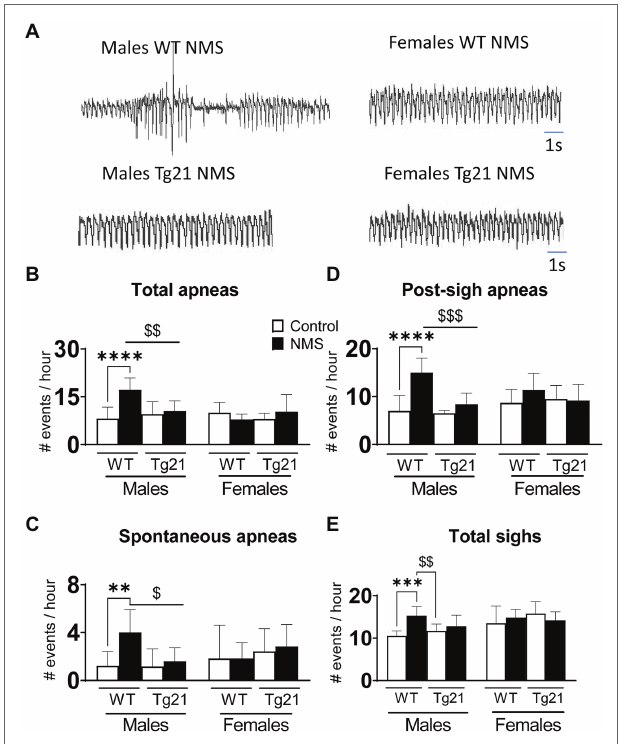
FIGURE 3 | Number of apneic (total, spontaneous, and post-sigh) and sighs events in male (WT: control n = 9; NMS n = 9; Tg21: control n = 7; NMS n = 7) and female (WT: control n = 6; NMS n = 6; Tg21: control n = 8; NMS n = 6) mice previously exposed (or not – control) to NMS. (A) Original recordings comparing resting respiration records between WT and Tg21 male and female animals exposed to NMS. The number of total (B) , spontaneous (C) , and post-sight apneas (D) and total sight (E) were significantly increased in NMS-exposed male WT mice. No effect of NMS was observed in male Tg21 mice, neither in WT or Tg21 female mice exposed, or not, to NMS. Data reported as means ± SD. * Indicates differences between treatments (controls vs. NMS). $ Indicates differences between strains (WT vs. Tg21). $: p < 0.05; ** , or $$: p < 0.01; *** , or $$$: p < 0.001; and **** : p <